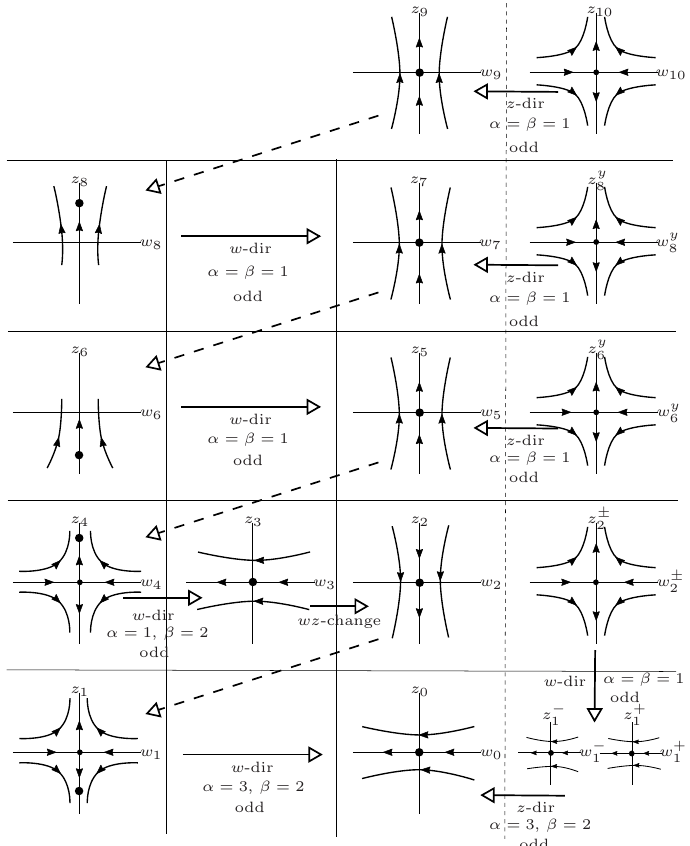
Figure 5 - The sequence of blow downs in the study of the origin of the chart U 2